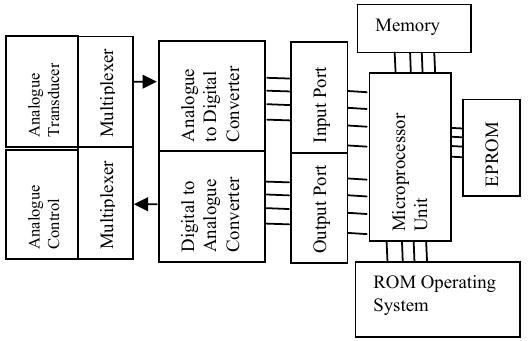
Figure 3: Schematic diagram of on-line chip for ANN tap changer